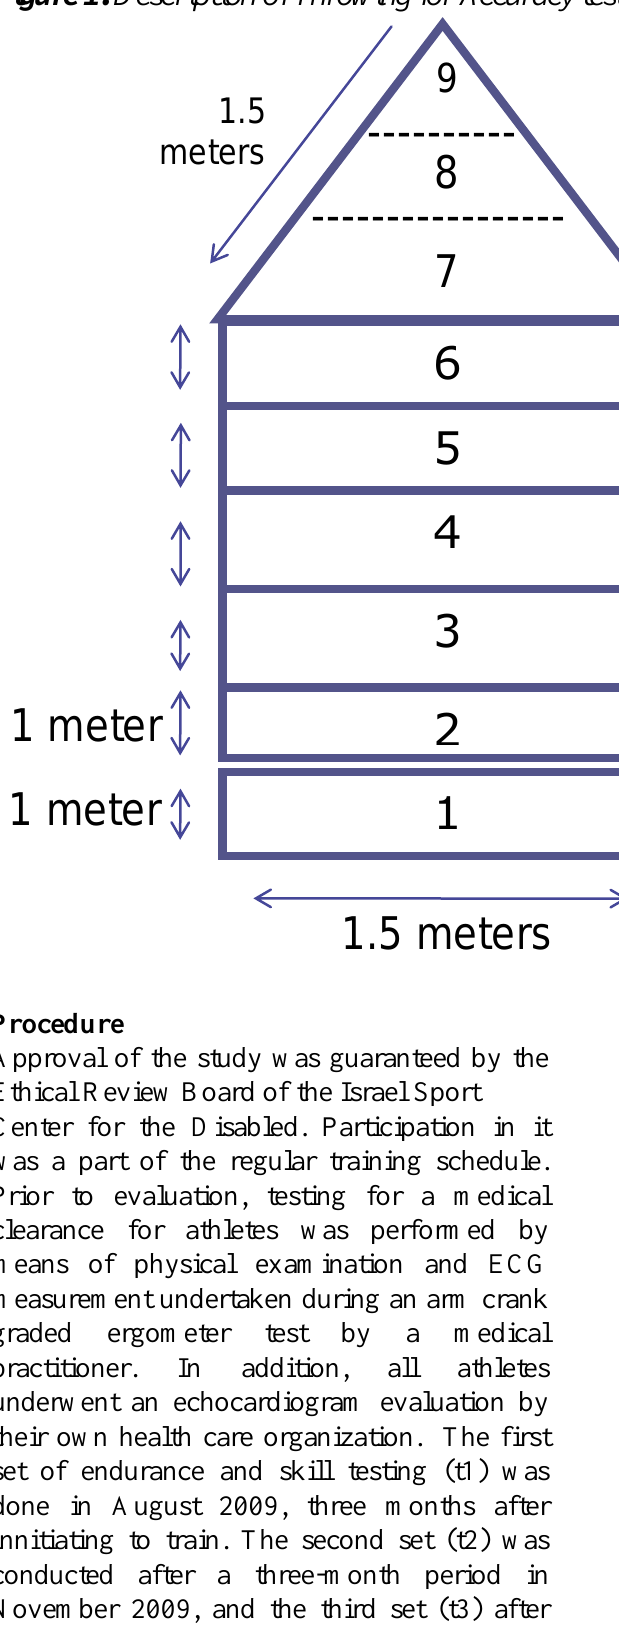
Figure 1. Description of Throwing for Accuracy test